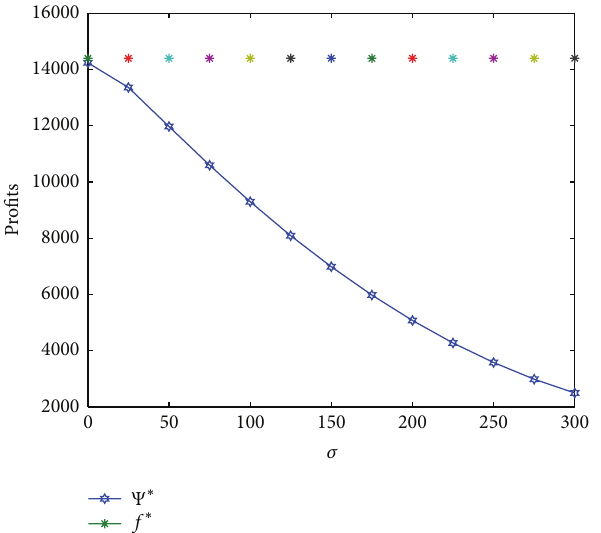
Figure 14: Impact of 𝜎 on the profits under demand certainty and uncertainty.